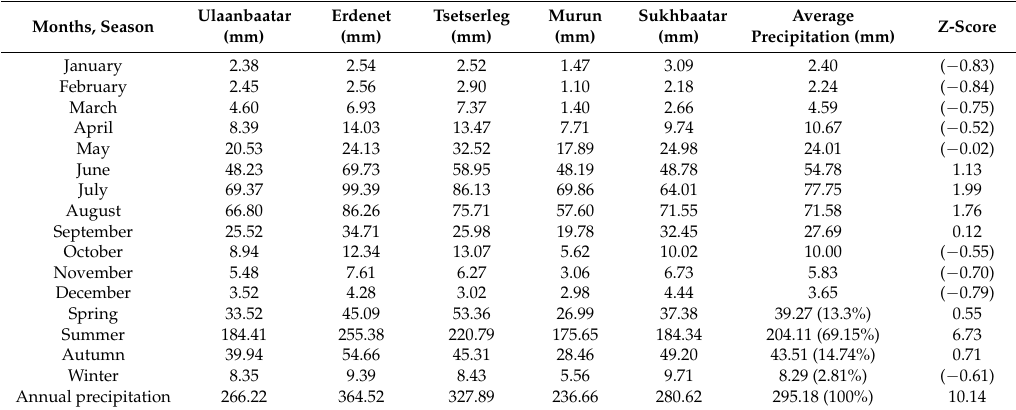
Table 1. The monthly and seasonal precipitation of stations.